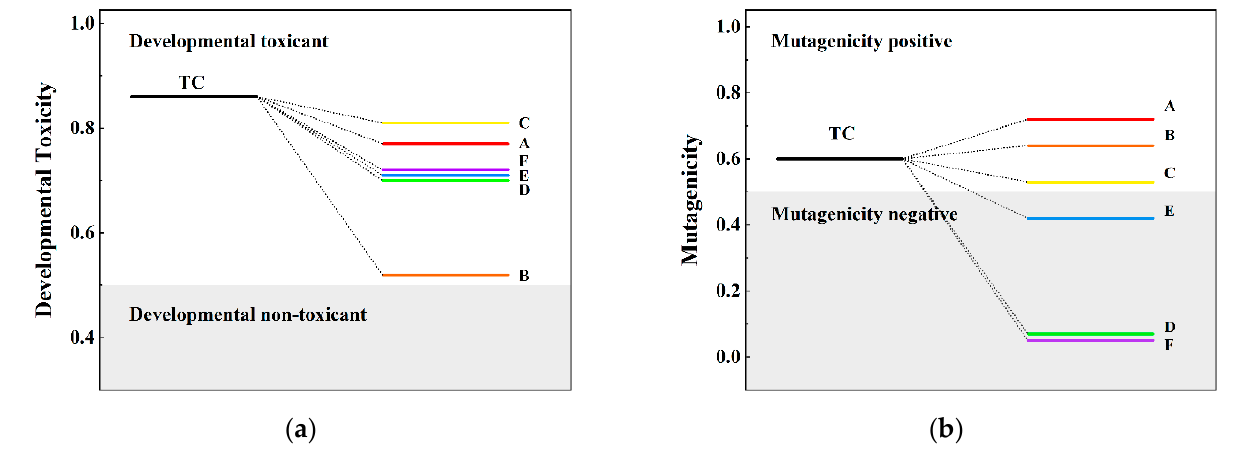
Figure 11. ( a ) Developmental toxicity and ( b ) mutagenicity of TC and the intermediates.